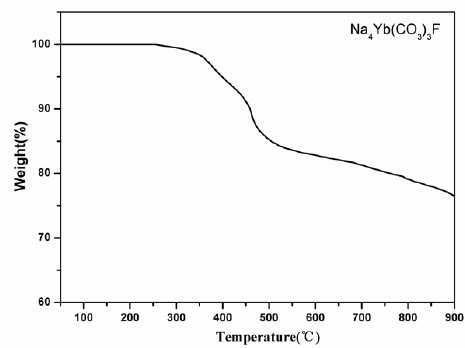
Figure 3. The thermogravimetric diagrams for Na 4 Yb(CO 3 ) 3 F.